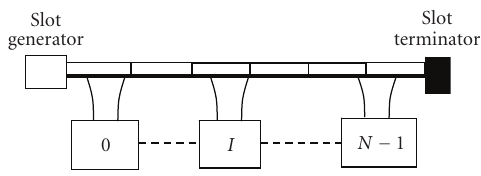
Figure 1: The structure of optical TDMA networks.